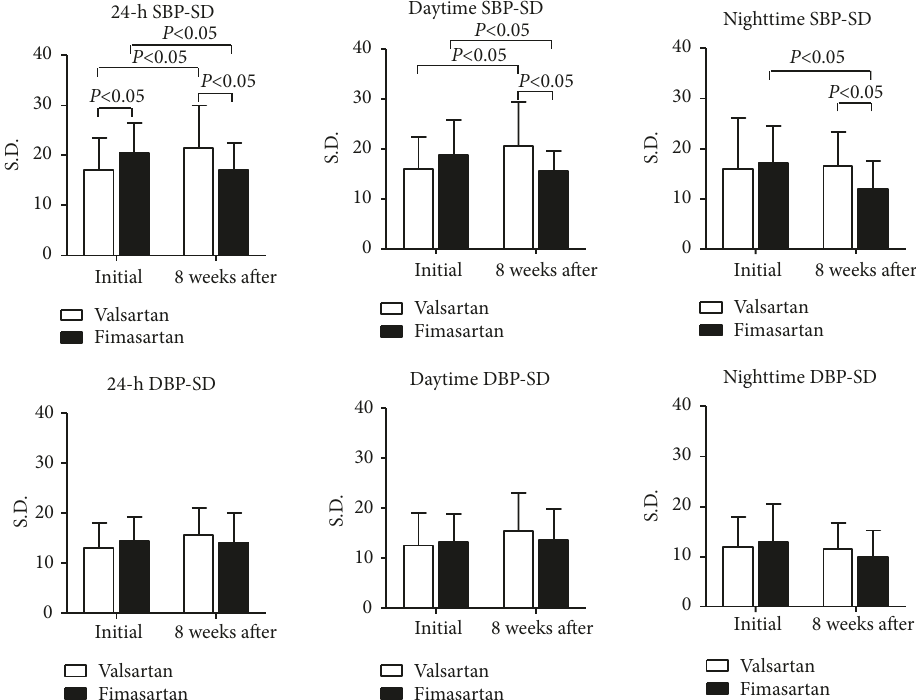
Figure 1: In paired test, while valsartan increased significantly SD of 24-hour, daytime, and nighttime systolic blood pressure (BP) from baseline, fimasartan reduced significantly SD of 24-hour, daytime, and nighttime of systolic BP from baseline. In comparison with valsartan, fimasartan reduced significantly SD of 24 hours, daytime, and nighttime of systolic BP after 8 weeks.